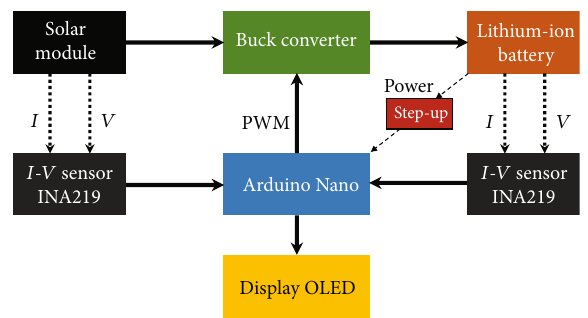
Figure 6: Block diagram of the designed SCC